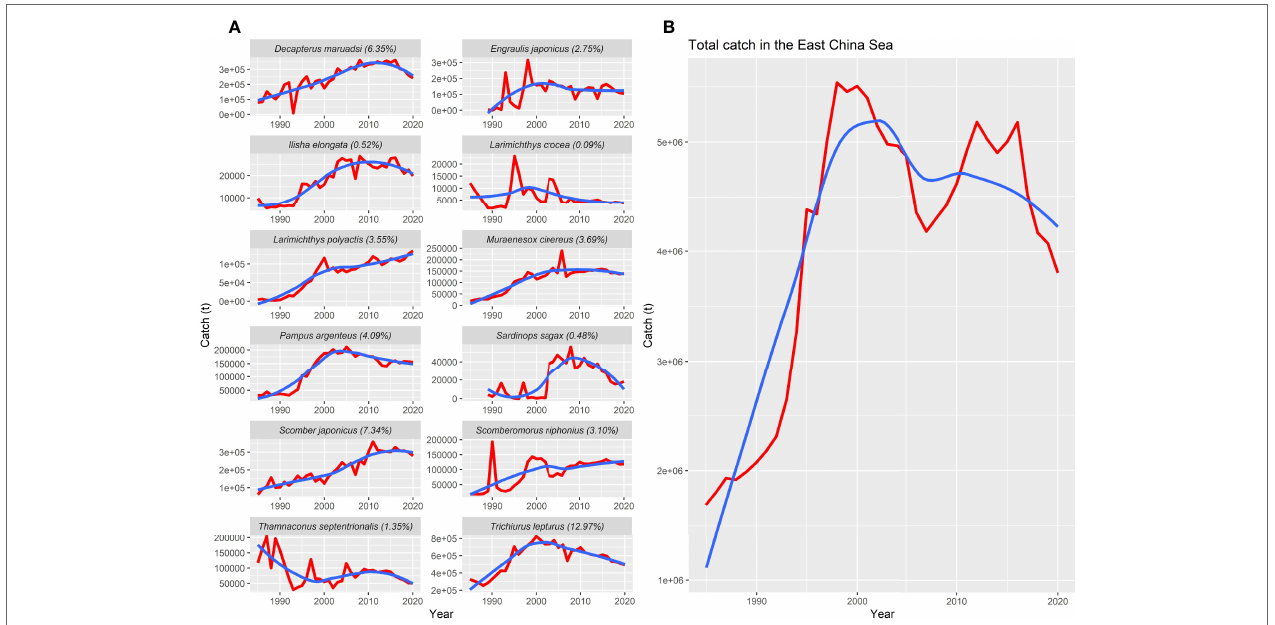
FIGURE 2 | Catch trends of main commercial species (A) and the total catch (B) in the ECS during 1985-2020. The starting years of catch time series differ due to data availability of species. The value in percentage in brackets denotes catch proportion of total. The red and blue lines are reported catch and loess smoothing curves,